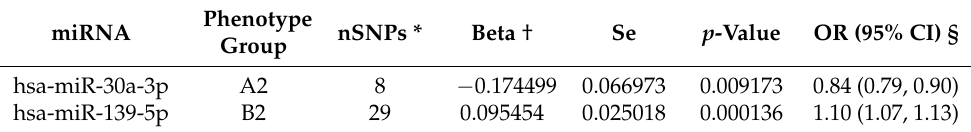
Table 2. High-confidence set of miRNA biomarkers for severe COVID-19 identified using indepen- dent miRNA eQTL data. miRNA